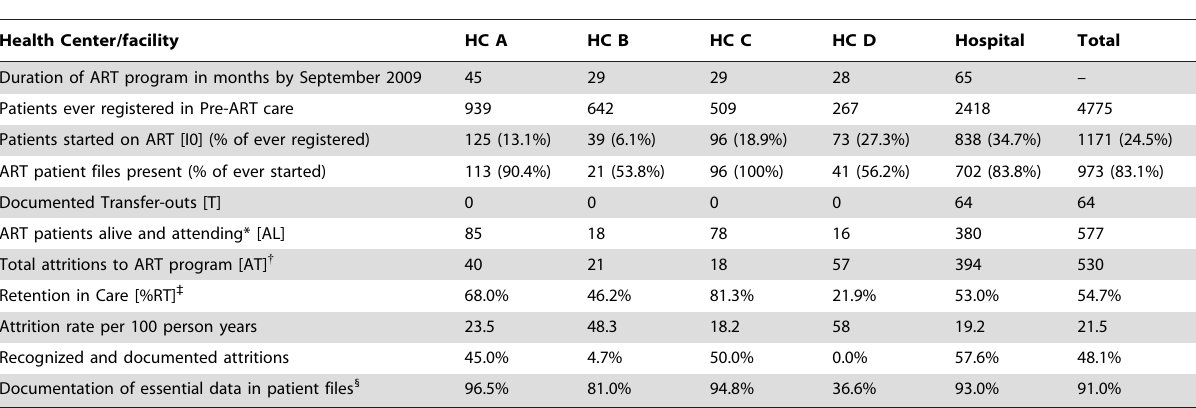
Table 1. ART program characteristics by health facility in Iganga District,